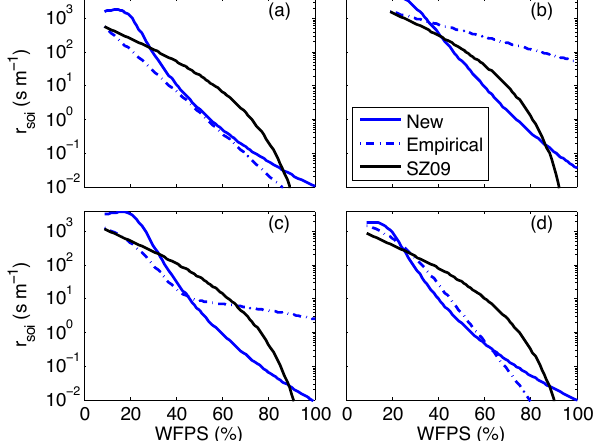
Figure 2. Comparison of calculated soil resistances by the measurement-derived 2 Fig. 2. Comparison of calculated soil resistances by the measurement-derived empirical equations and Eq. (13) for the four empirical equations and Eq. (13) for the four soils listed in Table 2. The CH 3 soils listed in Table 2. The CH parameterization is used for predic- parameterization is used for predictions with Eq. (13). For all cases, the vapor diffusivity 4 tions with Eq. (13). For all cases, the vapor diffusivity in air was assumed to be D 0 = 2 . 4 × 10 − 5 m 2 s − 1 . As specified by the inves- " 5 m 2 s -1 . As specified by the investigators of the 5 in air was assumed to be D 0 = 2.4 ! 10 tigators of the original publications, the TSCV thicknesses are 1, 5, original publications, the TSCV thicknesses are 1, 5, 2, and 2 cm for panels (a), (b), (c), 6 2, and 2 cm for panels (a) , (b) , (c) , and (d) , respectively. Note that the soil resistances are plotted on a log10 scale. and (d), respectively. Note that the soil resistances are plotted on a log10 scale. 7